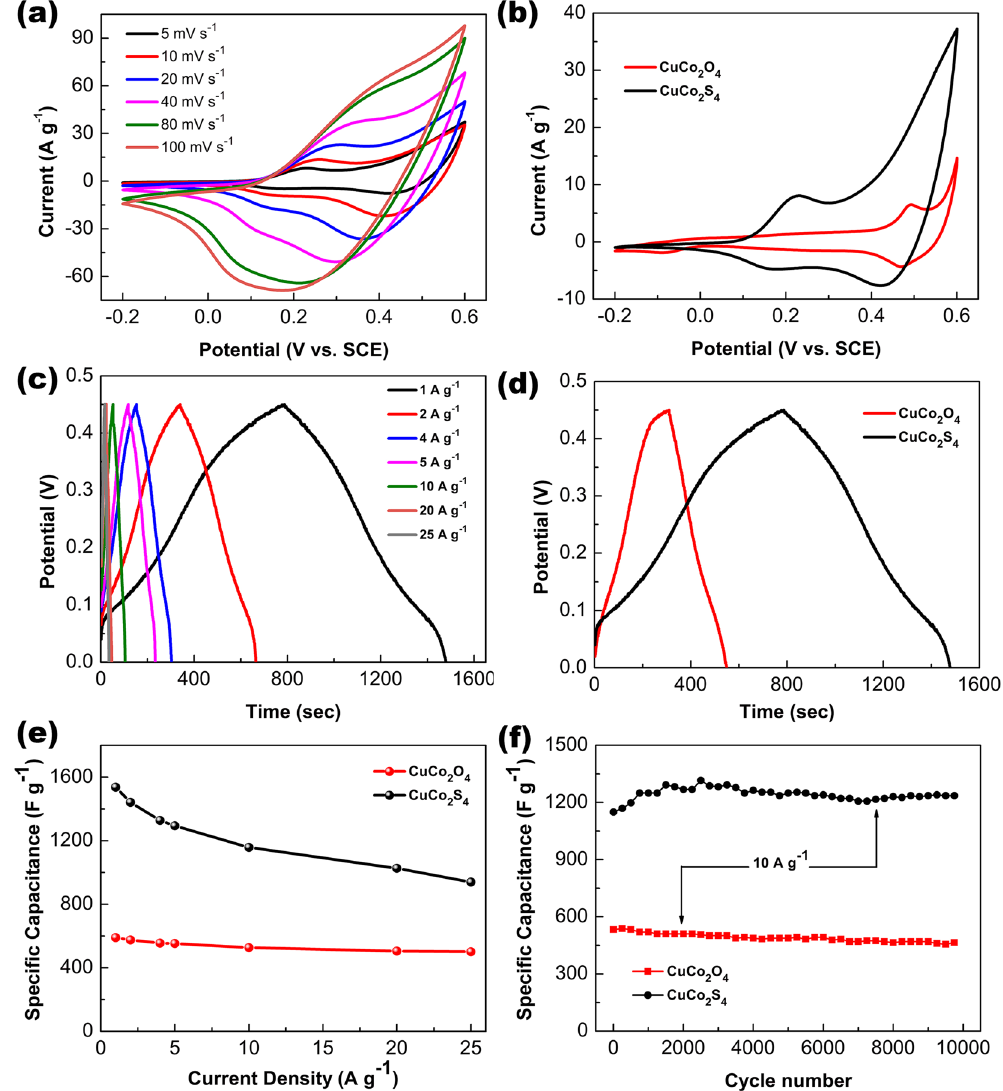
Figure 5. ( a ) CV and ( c ) galvanostatic charge-discharge curves of the CuCo 2 S 4 NRAs electrode at various scan rate and current densities, ( b ) CV and ( d ) galvanostatic charge-discharge curves of the CuCo 2 O 4 NWAs and the CuCo 2 S 4 NRAs electrodes recorded at a scan rate of 5 mV s − 1 and at a current density of 1 A g − 1 , ( e ) specific capacitances as a function of current densities for the CuCo 2 O 4 NWAs and the CuCo 2 S 4 NRAs electrodes, ( f ) cycling performance of the